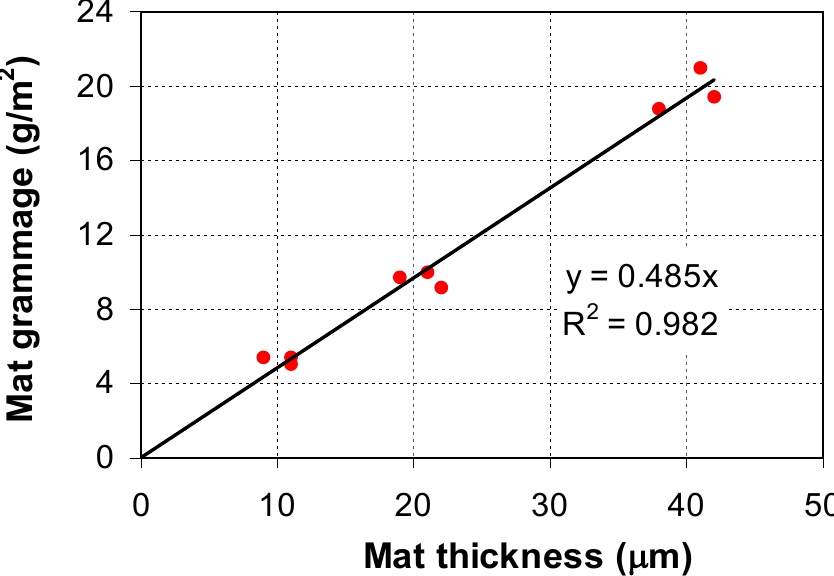
Figure 3. Grammage–thickness relationship of the produced n -60/40 mats.